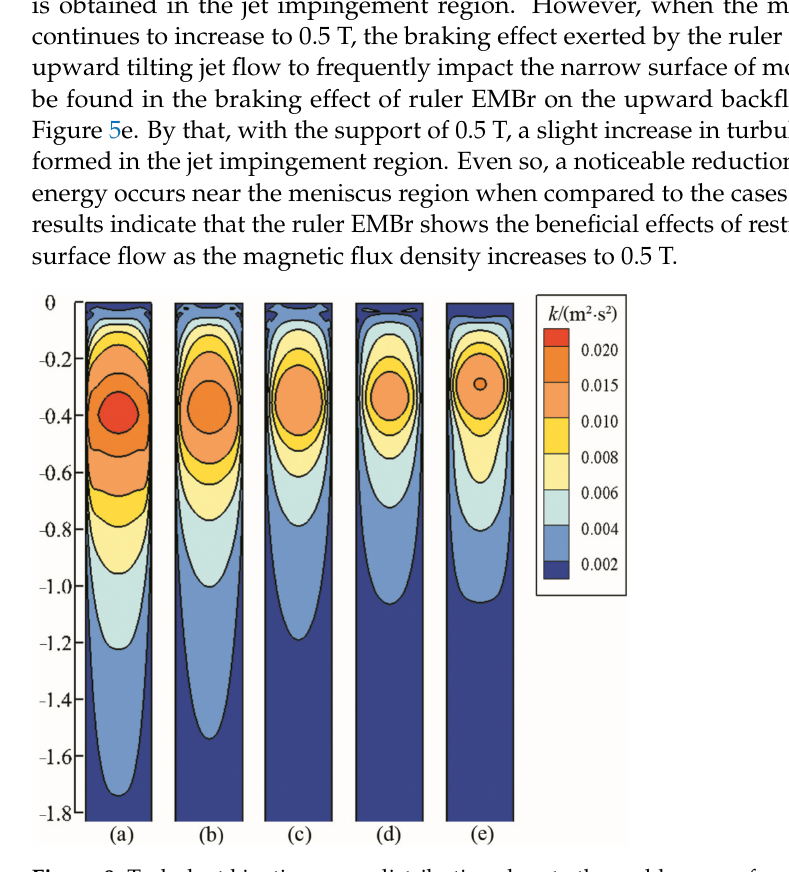
Figure 8. Turbulent kinetic energy distribution close to the mold narrow face with various magnetic flux densities: ( a ) B max = 0 T, ( b ) B max = 0.1 T, ( c ) B max = 0.2 T, ( d ) B max = 0.3 T and ( e ) B max = 0.5